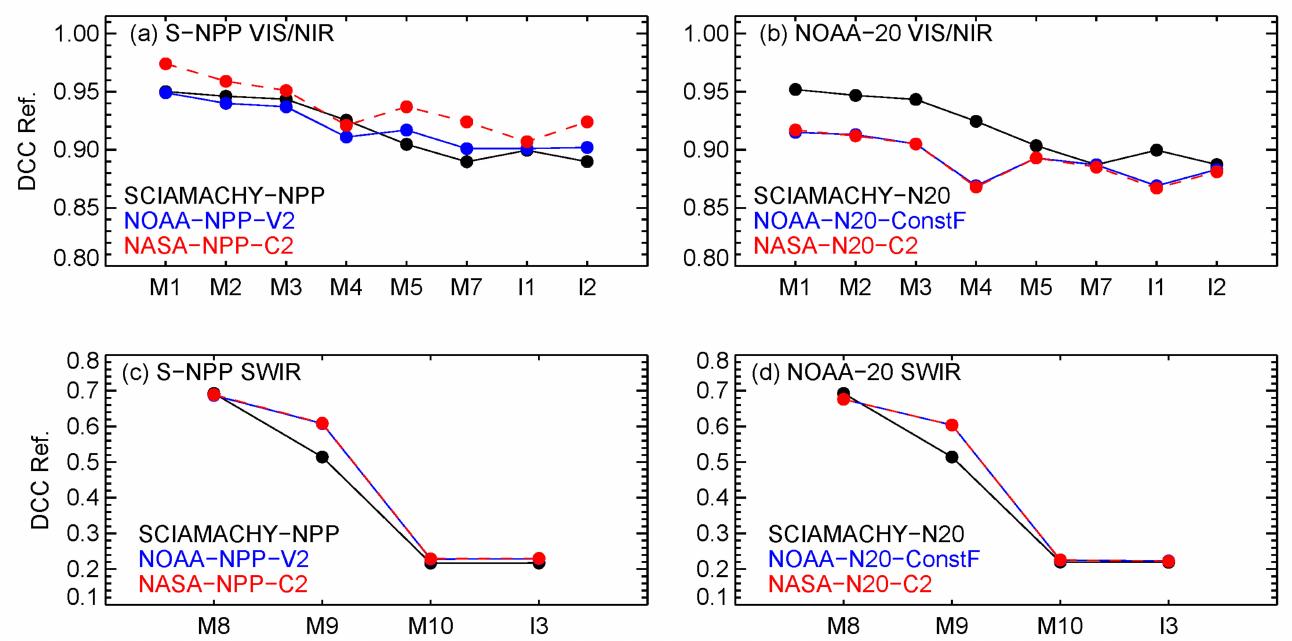
Figure 9. Inter-channel calibration consistency of the NOAA-20 and S-NPP RSBs: ( a ) S-NPP VIIRS VIS/NIR bands, ( b ) NOAA-20 VIIRS SWIR bands, ( c ) S-NPP VIIRS SWIR bands, and ( d ) NOAA-20 SWIR